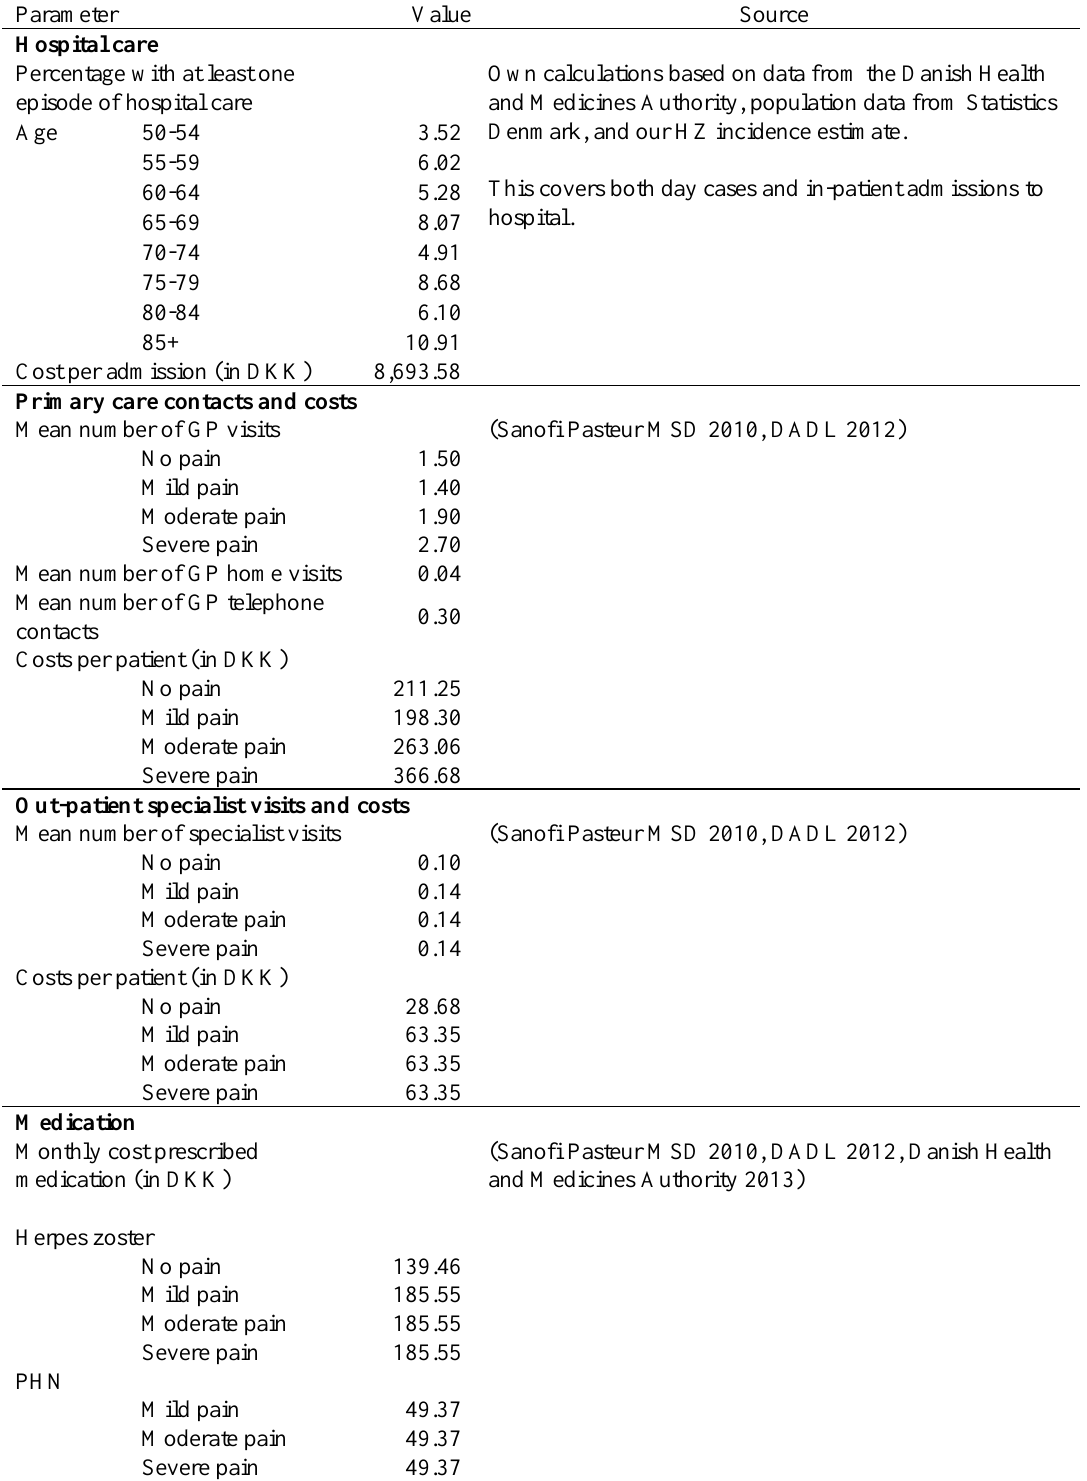
Table 2: Health care resource utilisation and costs Parameter Value Source Hospital care Own calculations based on data from the Danish Health and Medicines Authority, population data from Statistics Denmark, and our HZ incidence